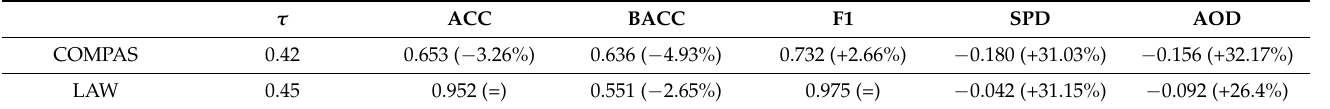
Table 6. LRC performance results for adapted discrimination thresholds. Performance was evaluated us- ing stratified 10-fold CV. For SPD and AOD, values closer to zero indicate more fairness. The percentages in brackets display the differences compared to the baseline results as presented by Table